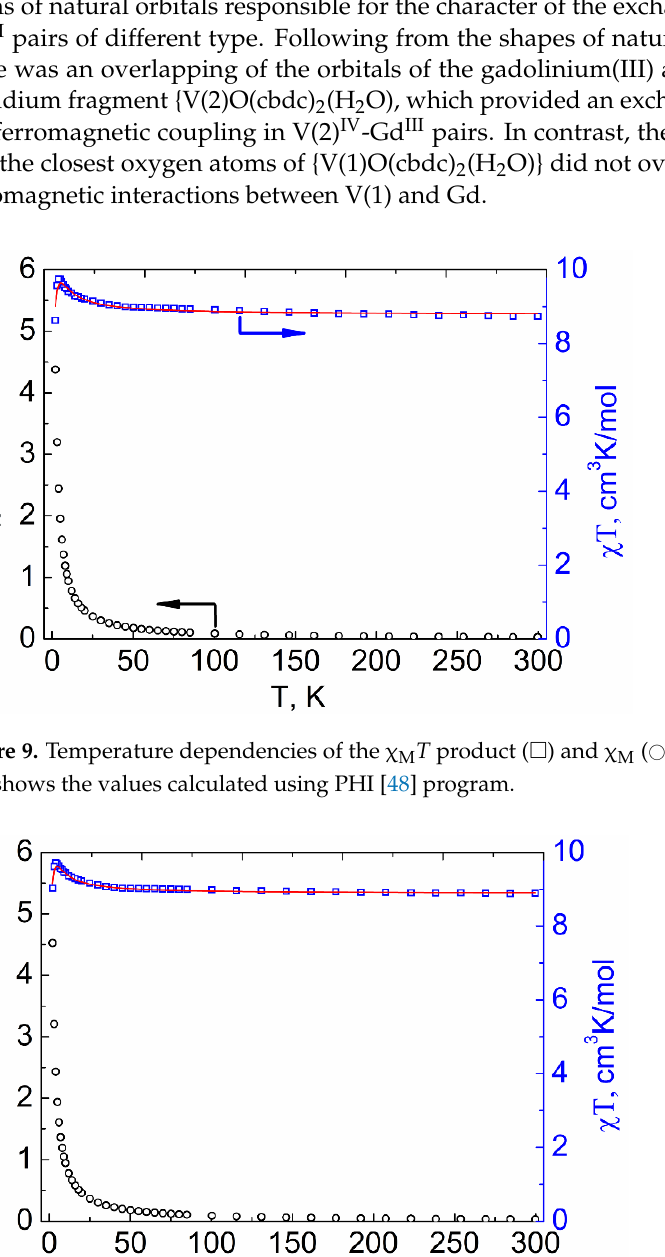
) for compound 3 . The red (cid:35)